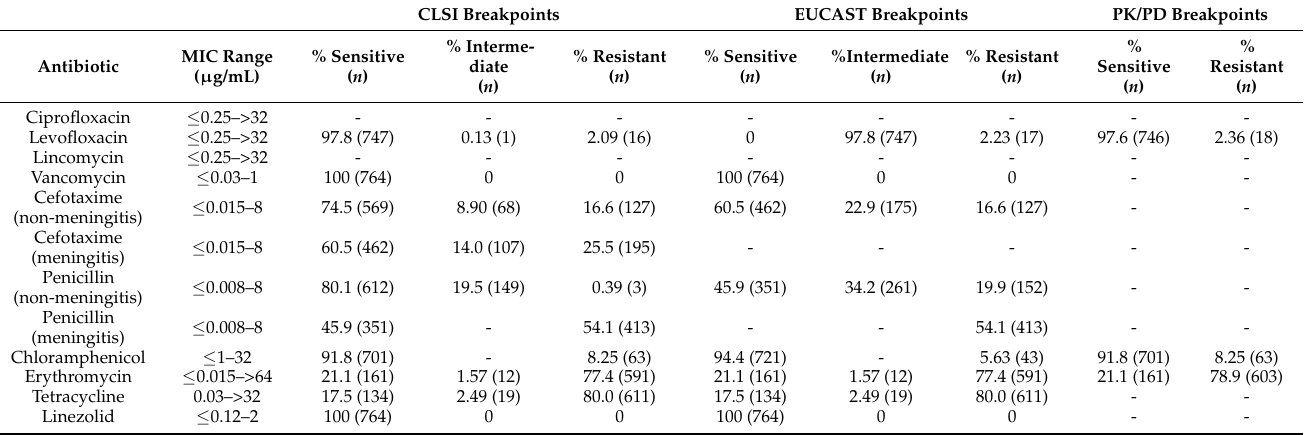
Table 5. Comparison of antimicrobial non-susceptibilities of Streptococcus pneumoniae using CLSI, EUCAST and PK/PD breakpoints of 764